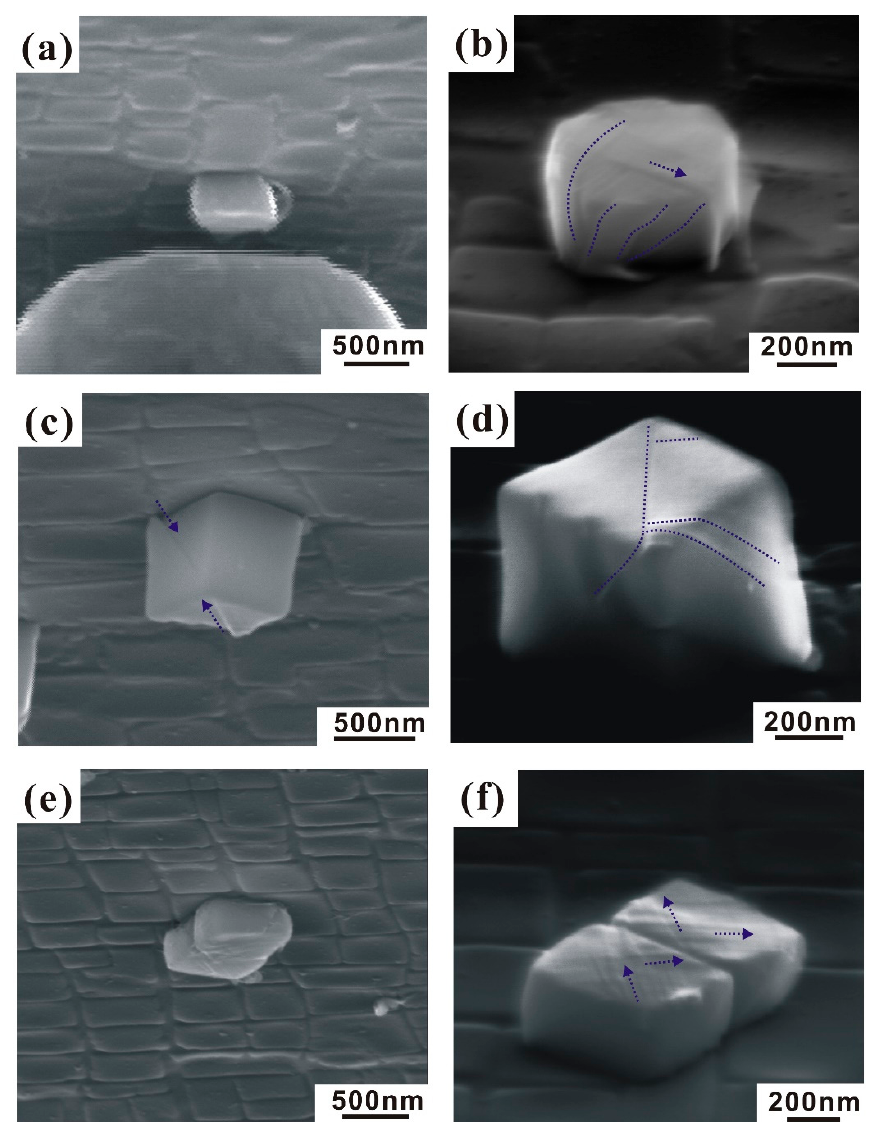
Figure 6. Slip morphologies of as-extracted Ni 3 Al nanocubes after compression. ( a , b ) Short cuboid; ( c , d ) perfect cube; ( e , f ) double cube.